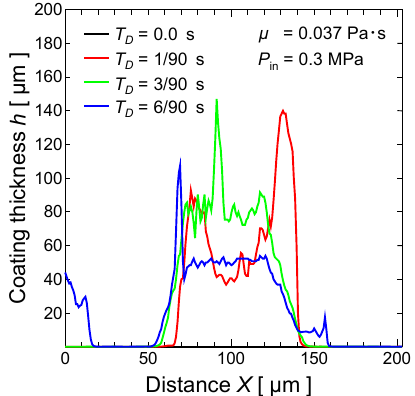
Figure 6. Coating thickness on a red line in Figure 5.